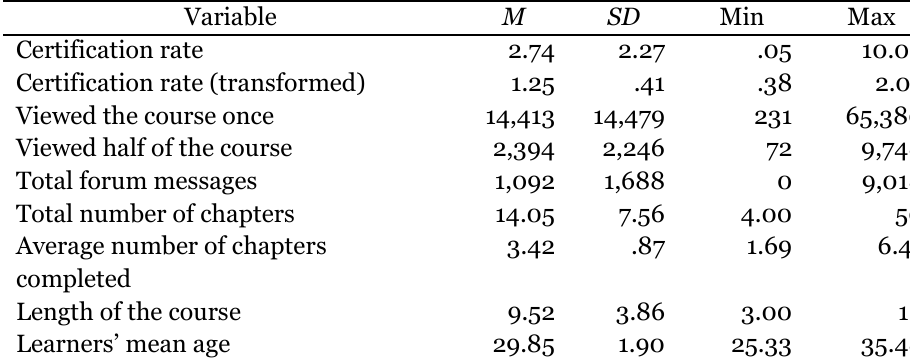
Descriptive Statistics of Outcome and Predictor